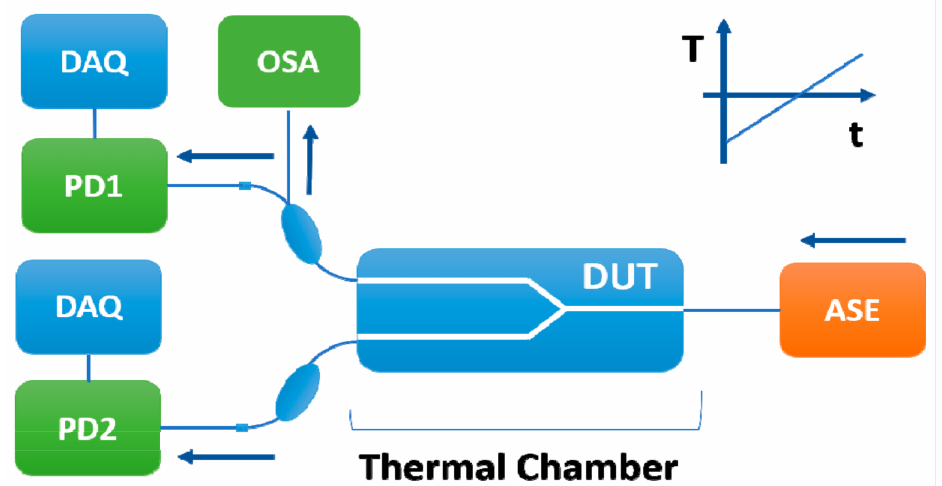
Figure 2. The schematic diagram for measuring IOM transmission characteristics (where DAQ—data acquisition unit; OSA—optical spectrum analyzer; PD1 and PD2—photodetectors; ASE—amplified spontaneous emission source; DUT—device under test; T—temperature;